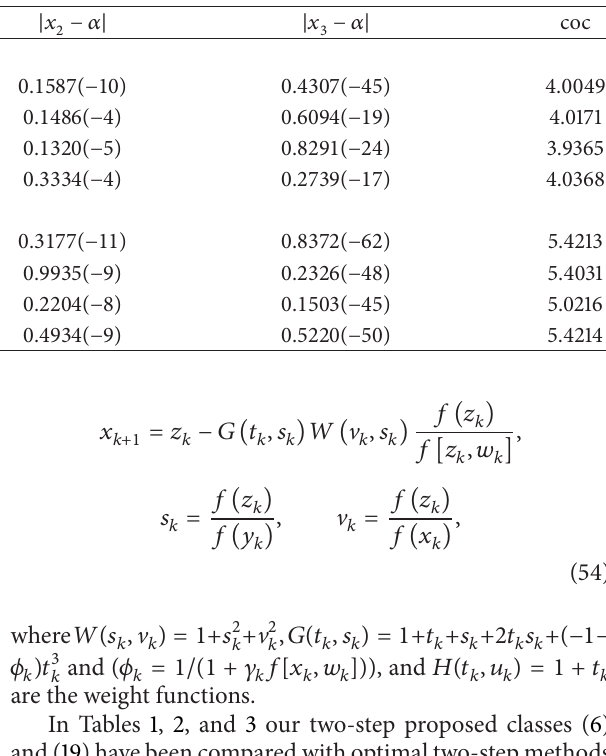
2 +𝑥 cos (𝑥)−1) + 𝑥 log (𝑥 sin (𝑥) + 1),𝛼 = 0 , and 𝑥 0 = 0.6